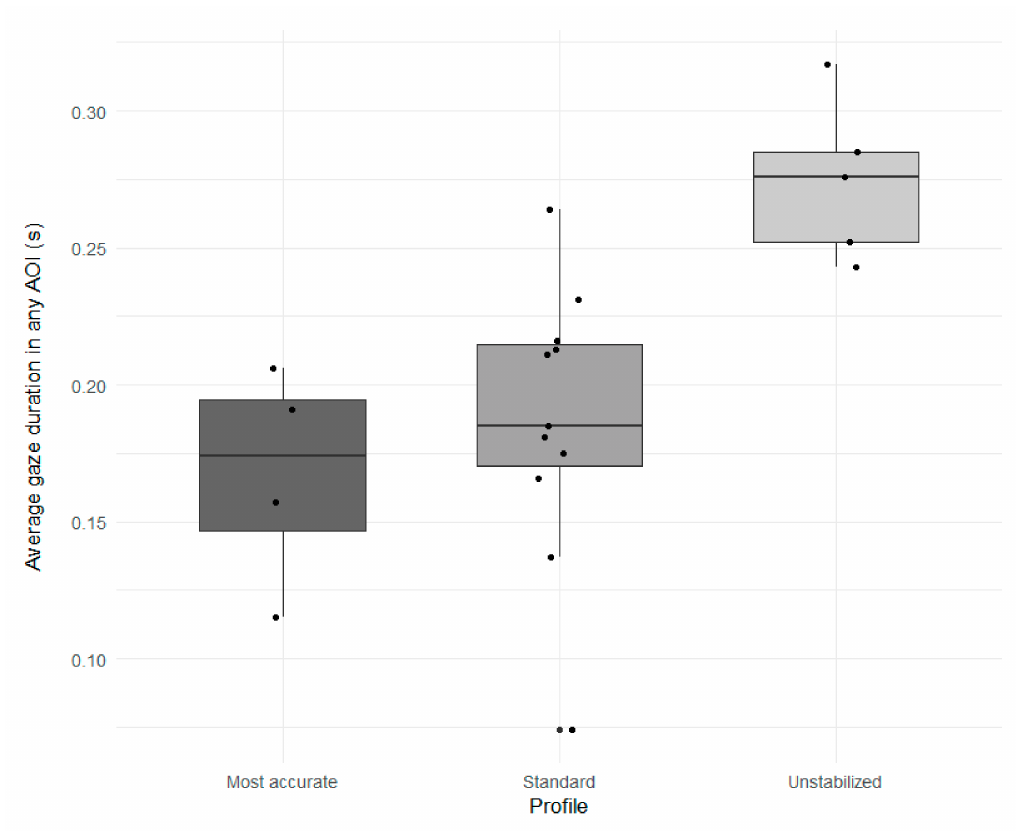
Figure 7. Average dwell time in the AOI (s) for each pilots’ performance profile (pre-training session, dots represent individual